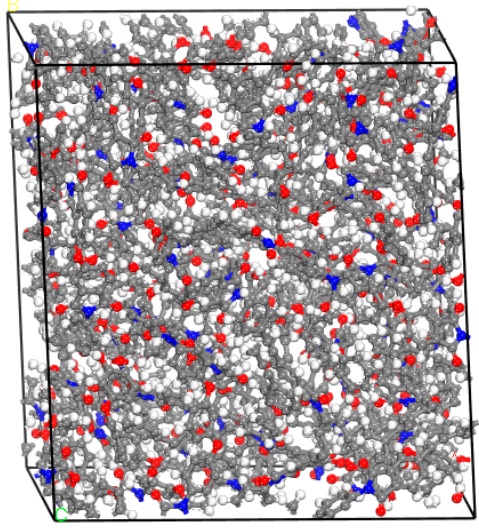
Figure 2. The amorphous structure of the ODPA-APB PI